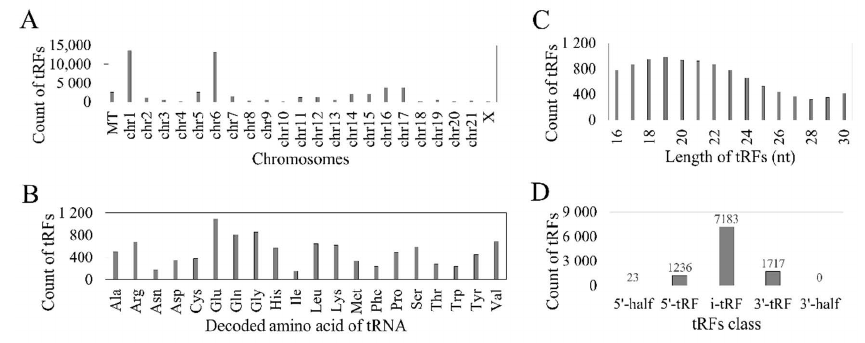
Figure 1. Overview of reported tRFs in the TCGA HNSC cohort. ( A ) Potential mapping of tRFs at mitochondria (MT) and different chromosomes. ( B ) Corresponding tRNA decoded amino acids (three letter code). ( C ) Length-wise distribution of tRFs. ( D ) Count of fragments according to the five tRF classes.